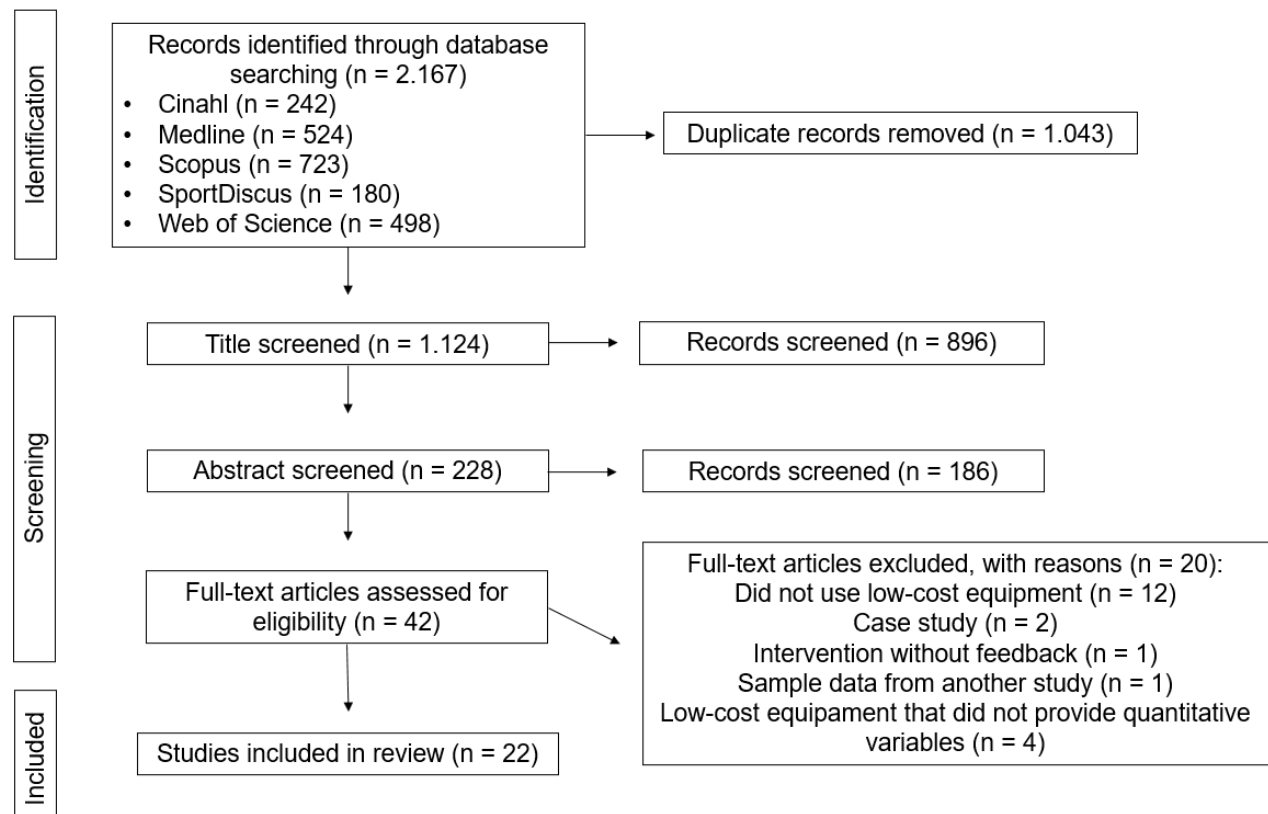
Figure 1. Preferred Reporting Items for Systematic Reviews and Meta-Analyses (PRISMA) flowchart of the included studies.